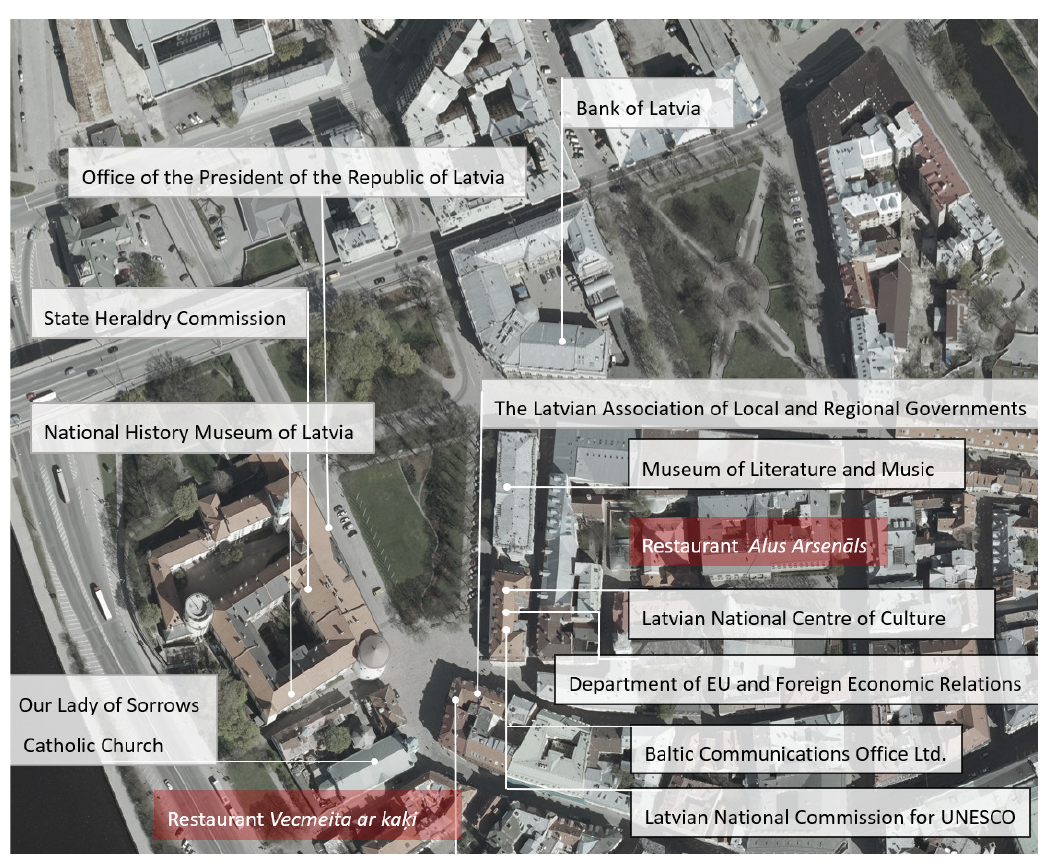
Figure 7. Institutional profile of the Castle Square, 2009–2022. one or two requirements to a larger or lesser